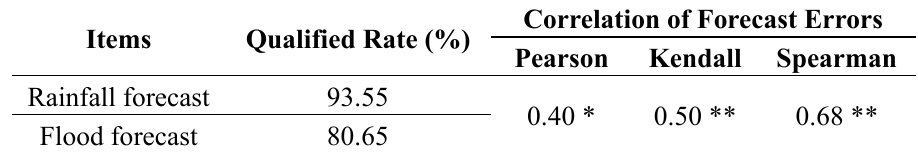
Table 3. Accuracy of floods and correlation of forecast errors for DHF reservoir.